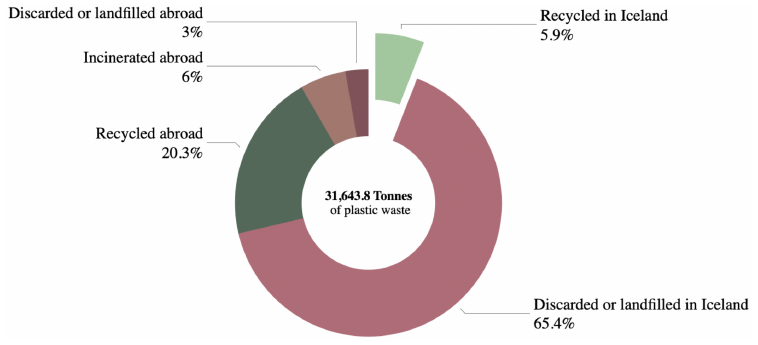
Figure 1. Fate of plastics waste in Iceland in 2019